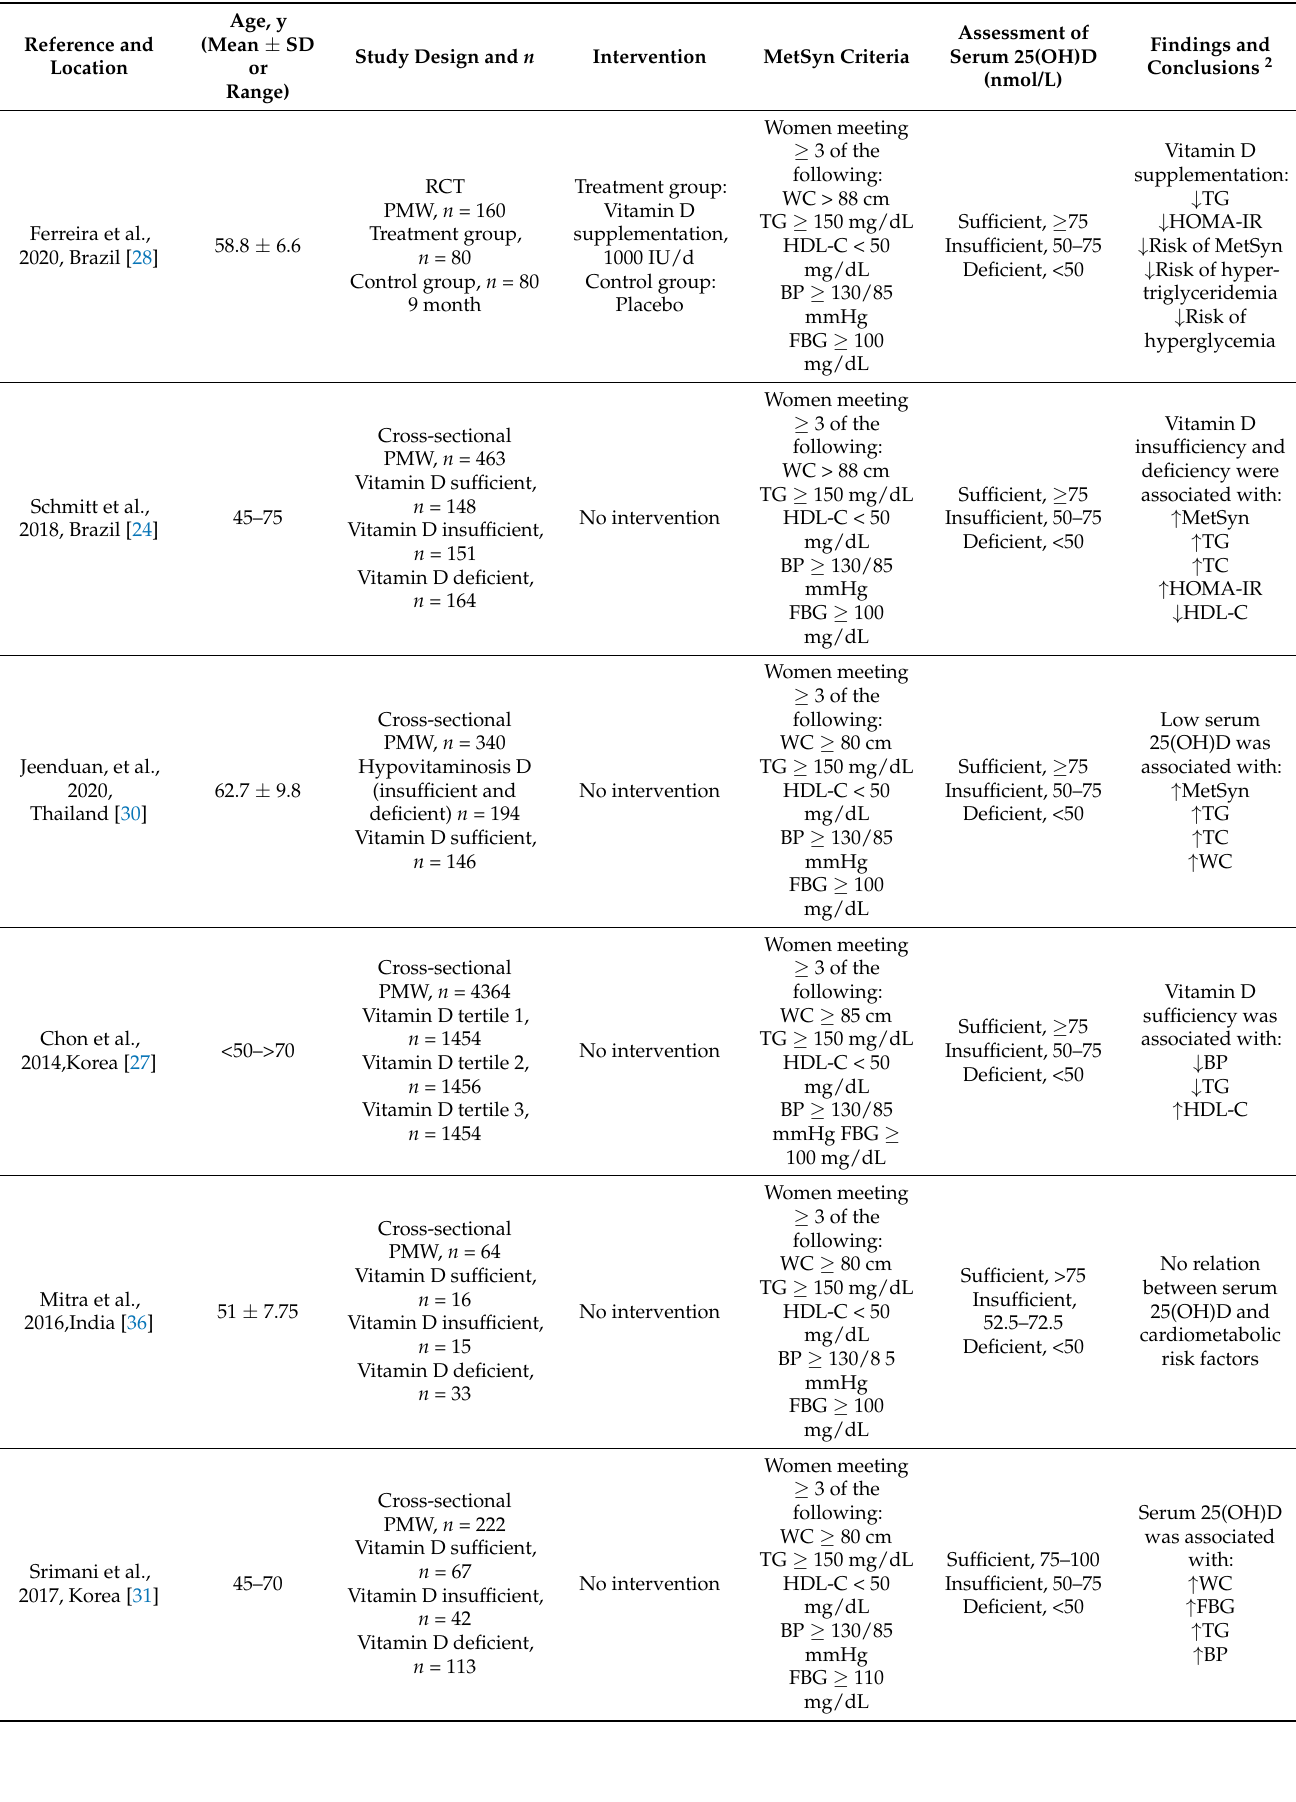
Table 1. Summary of studies on serum 25(OH)D concentrations and MetSyn in postmenopausal women 1